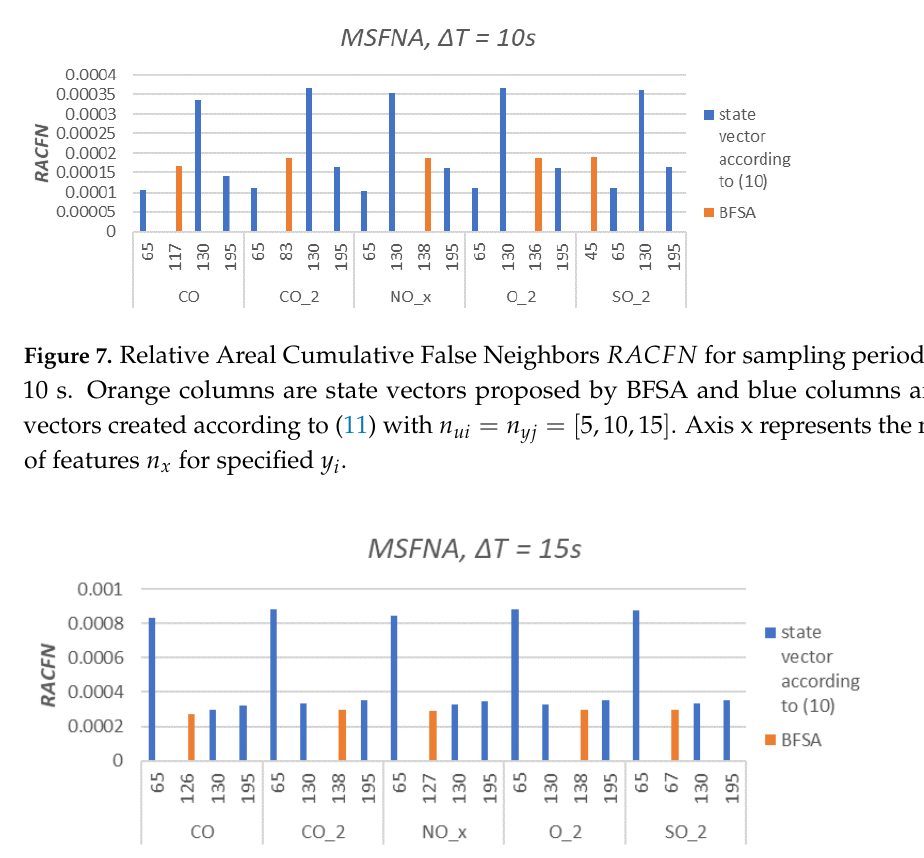
Figure 8. Relative Areal Cumulative False Neighbors RACFN for sampling periods ∆ T = 15 s. Orange columns are state vectors proposed by BFSA and blue columns are state vectors created according to (11) with n ui = n yj = [ 5, 10, 15 ] . Axis x represents the number of features n x for specified y i